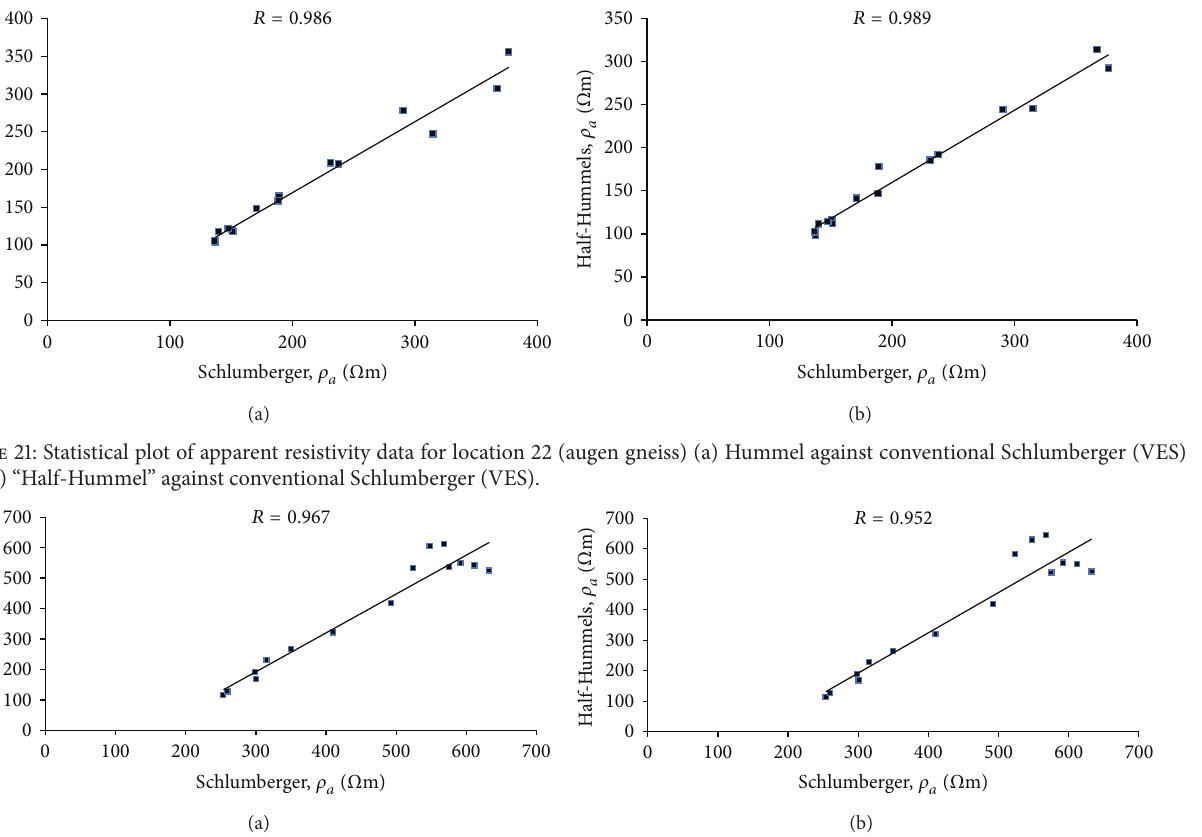
Figure 20: Bar chart and statistical test of hypothesis table for the different array methods comparing basement resistivity for locations on augen gneiss.